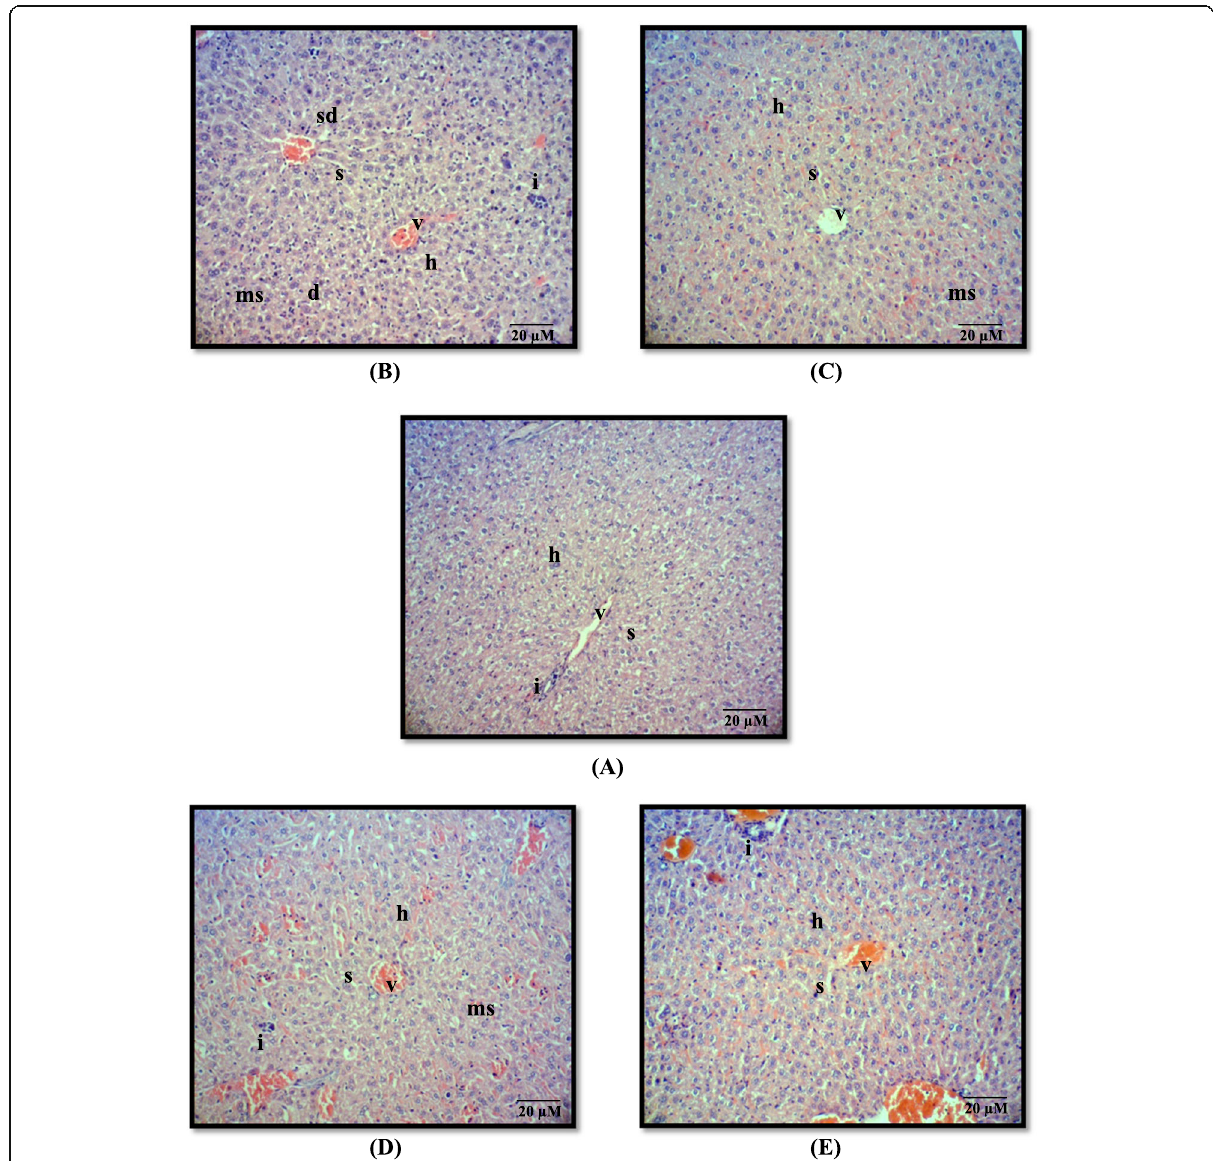
Fig. 3 Micrograph of H&E sections from mice liver treated with ( a ) acetone (Group I, vehicle control); ( b ) DMBA/TPA (Group II, carcinogen control); ( c ) 85 nM annonacin (Group III, treatment); ( d ) 85 nM annonacin only (Group IV, treatment control); ( e ) 10 mg/kg curcumin (Group